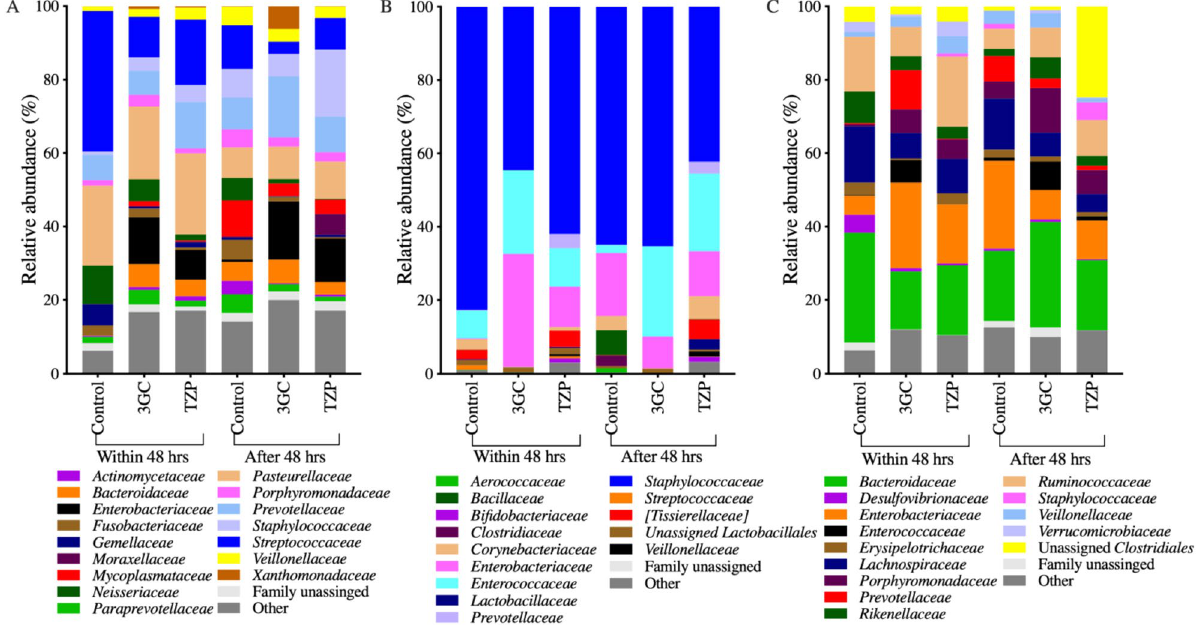
Figure 2. Family level taxonomic composition of the ( A ) endotracheal, ( B ) perineal and ( C ) faecal microbiota samples collected within and after 48 h of antibiotic administration (for 3GC and TZP groups) or admission to the ICU (control group). 3GC-third-generation cephalosporins, TZP-piperacillin/tazobactam, control-no β-lactams. OTUs that were not assigned to a family are categorised as “Family unassigned”. Bacterial families with a relative abundance less than 3% in all three treatments for each body site are grouped as “Other”. Family level taxonomic abundance for each patient is shown in Supplementary Fig. S3 with details on the sample size per treatment group provided in Supplementary Table S1. The relative abundance of the 16S rRNA gene amplicons in the families were determined using QIIME and graphed using GraphPad Prism (version 9, GraphPad Software, USA, www. graph pad.